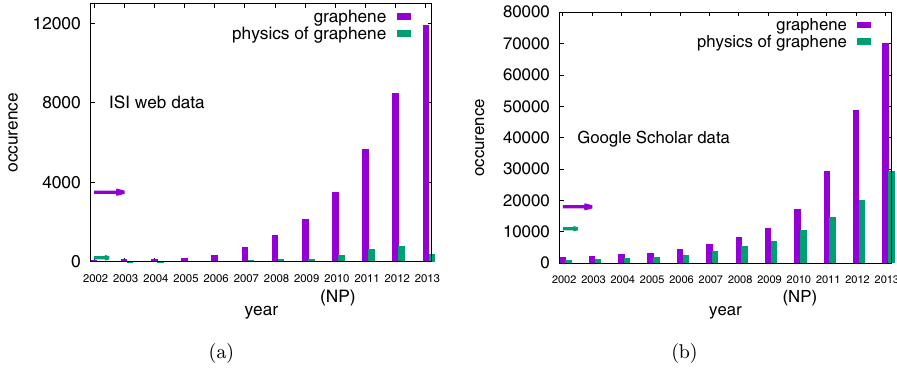
Fig. 1. (a) The number of papers on graphene listed in ISI Web of Science around the year the Nobel prize was awarded in graphene (2010); (b) The same is shown for the Google Scholar